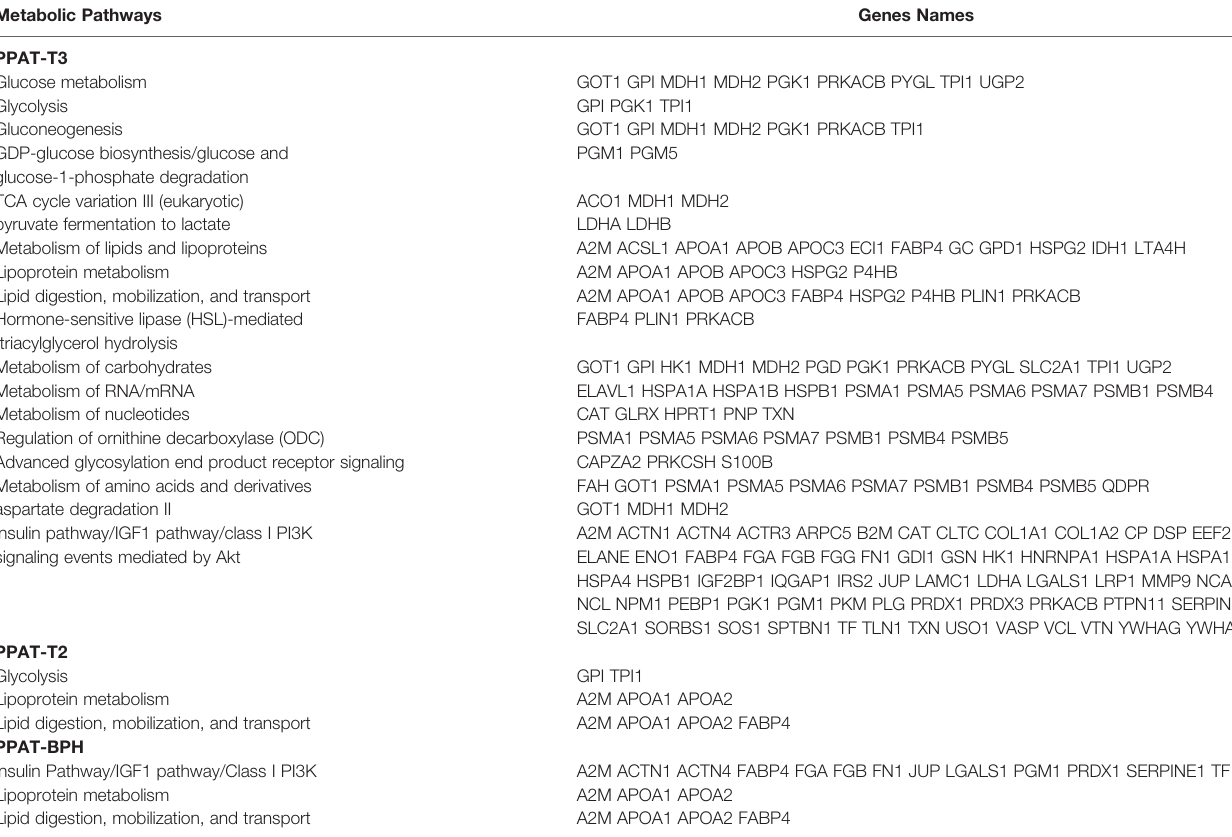
TABLE 1 | Detected genes in the prostate tumor microenvironment associated with the enriched metabolic pathways. Metabolic